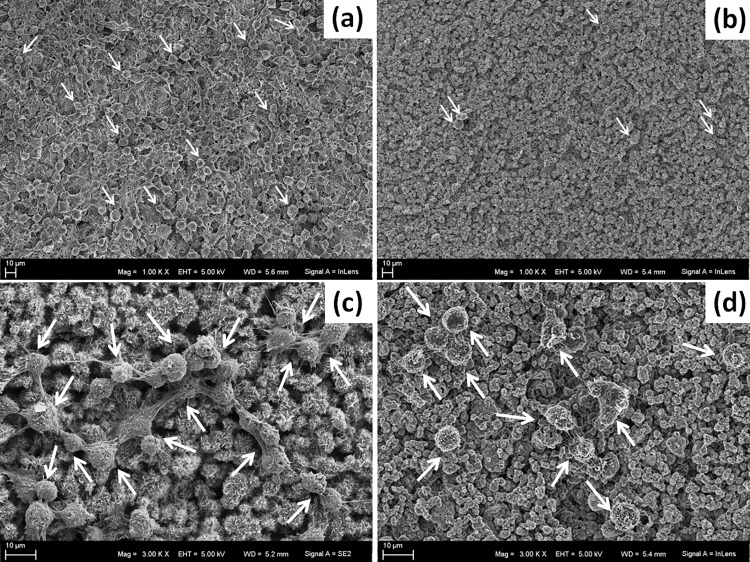
SEM of cells on substrates.Representative SEM micrographs of cells incubated on substrates for 3 days, a) C-HA and b) F-HA at low magnification (1000x); c) C-HA and b) F-HA at higher magnification (3000x). Arrows pointing on some of the cells.